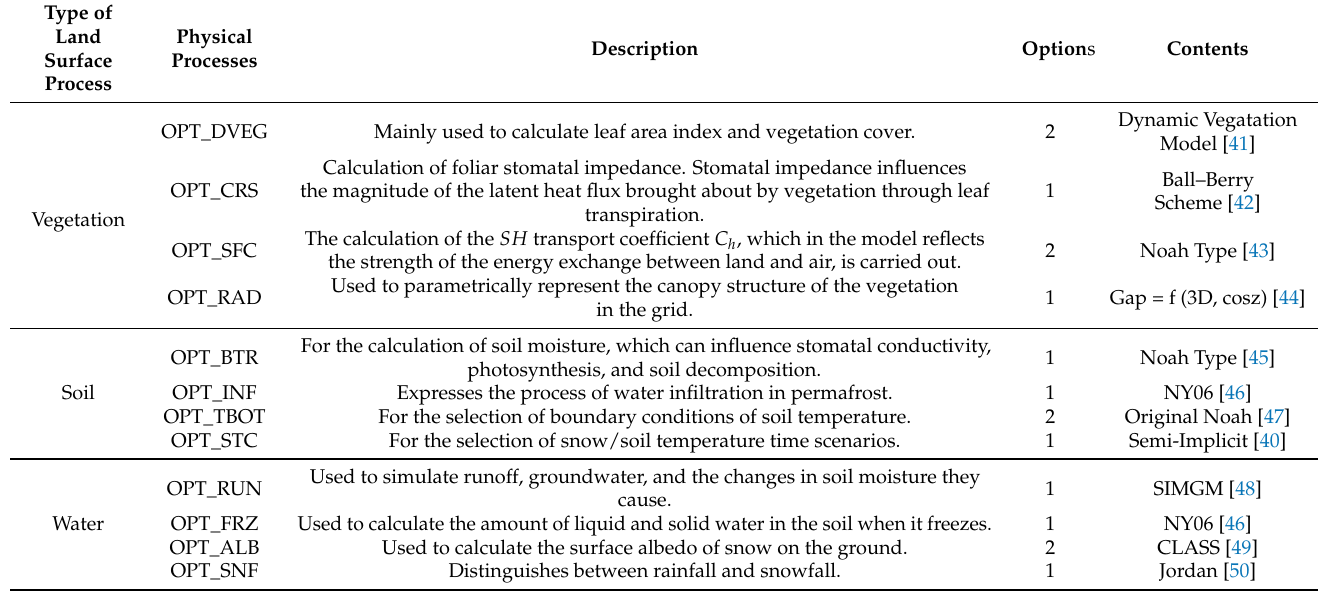
Table 1. The setup options of the Noah-MP land surface